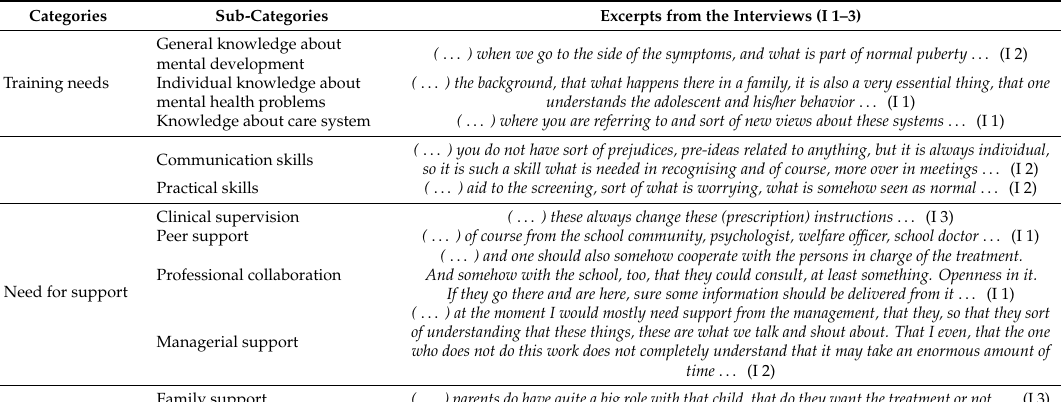
Table 2. School nurses’ need for training and support at